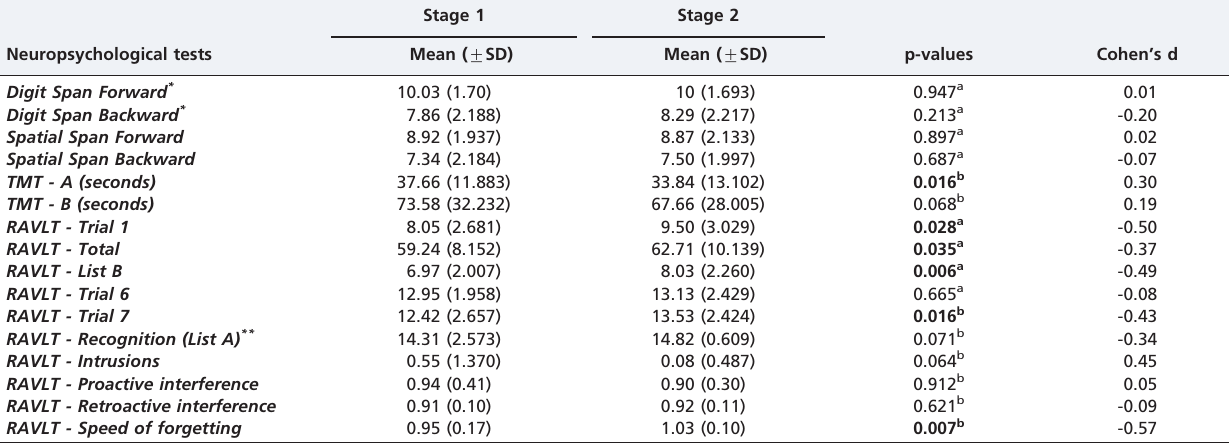
Table 2 - Cognitive performance of internal medicine residents after Stage 1 and Stage 2 (n=